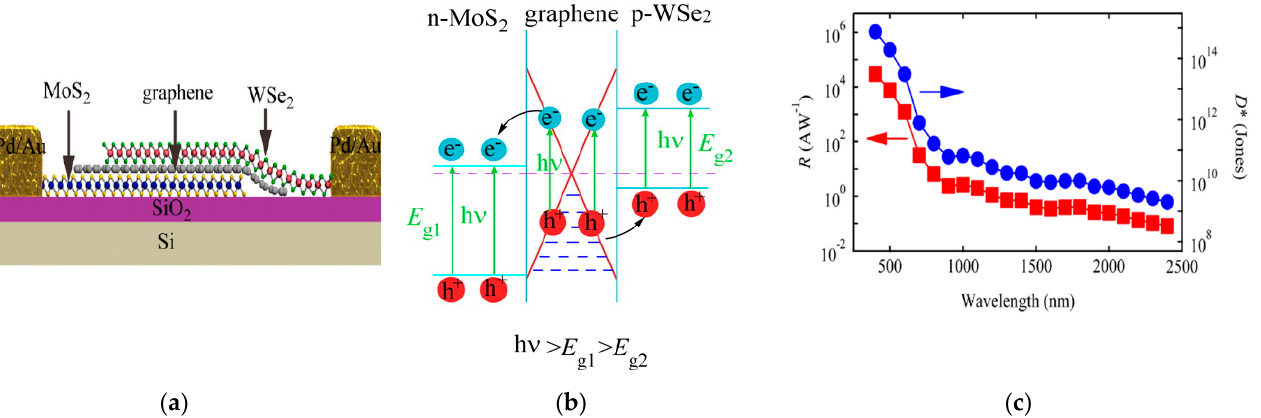
Figure 19. ( a) Scheme of a phototransistor based on the vertical heterostructure between MoS 2 , graphene and MoSe 2 . ( b ) Band alignment at the heterojunction between TMDs and graphene; ( c ) responsivity and detectivity values plotted against the incident wavelength for the phototransistor over the vis-IR spectrum. Reprinted with permission from ref. [33]. © 2016, American Chemical Society.